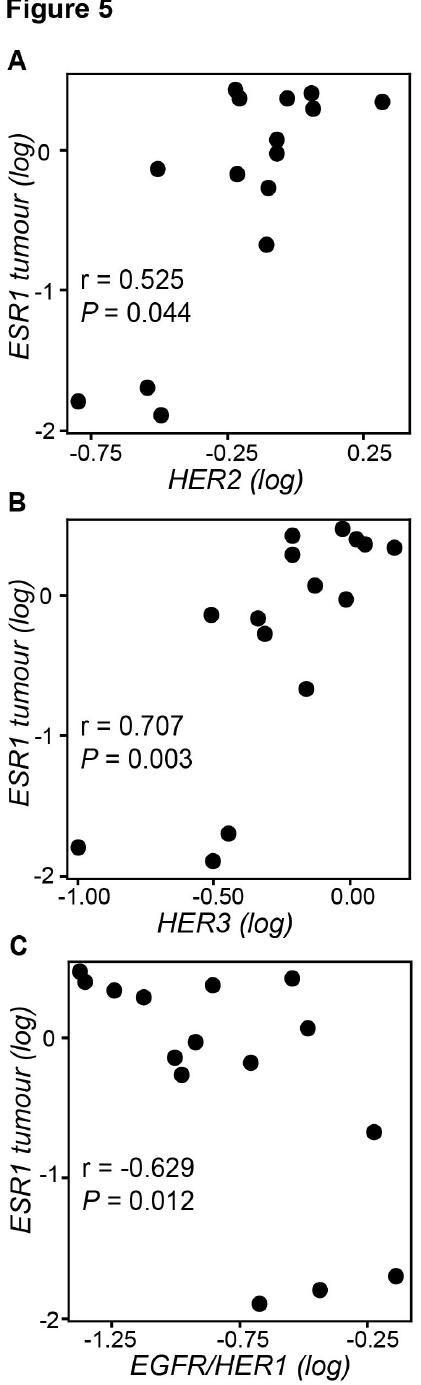
Figure 5. Intratumoural correlations of growth factor receptors with estrogen receptor mRNA levels ( ESR1 ). Scatterplots illustrate correlations of HER2 (A), HER3 (B) and EGFR/HER1 (C) with ESR1 among postmenopausal women. HER2 amplified tumours are excluded. Significant correlations were evaluated using the Spearman rank (two- tailed) test. doi: 10.1371/journal.pone.0074618.g005 PLOS ONE |